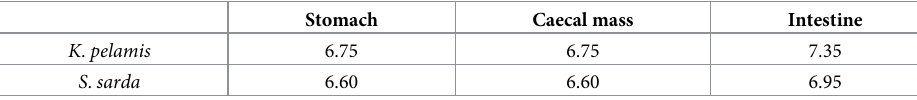
Table 2. pH values used for enzymatic analysis.